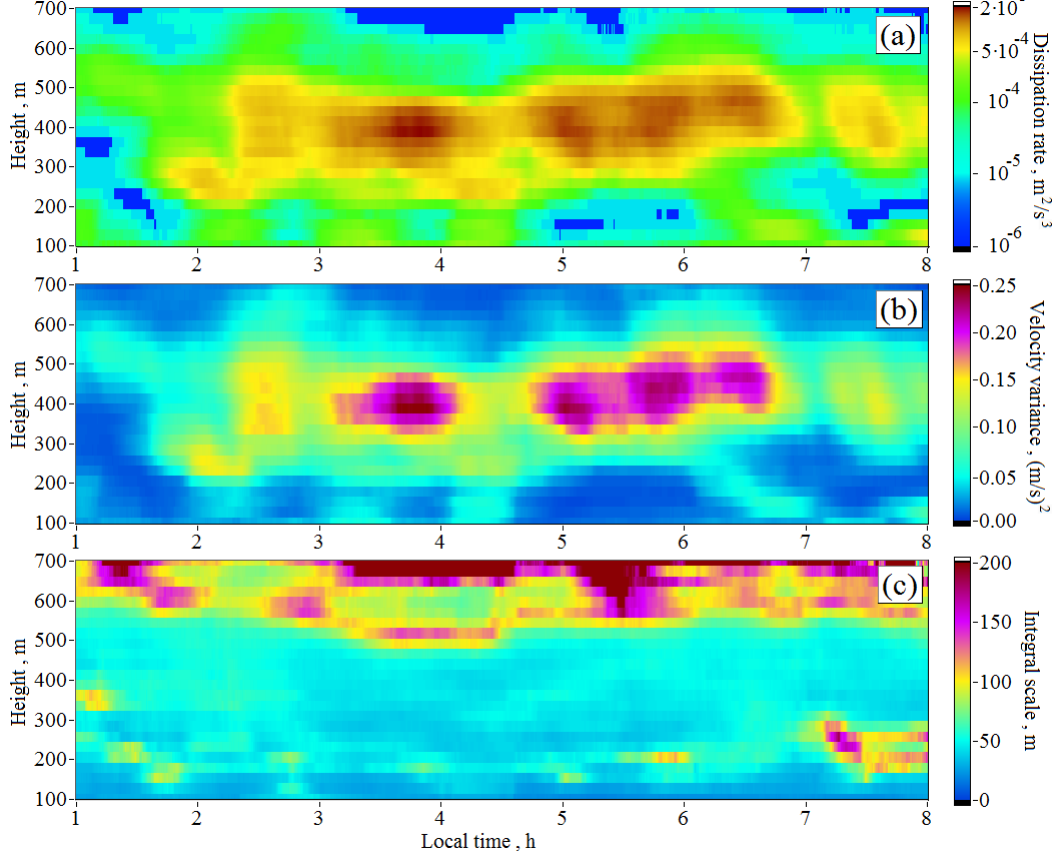
Figure 8. Height and time distributions of the turbulence energy dissipation rate ( a ), variance of turbulent fluctuations of the radial velocity ( b ), and the integral scale of turbulence ( c ) as obtained from measurements by the StreamLine lidar at the Lake Baikal coast on 24 August